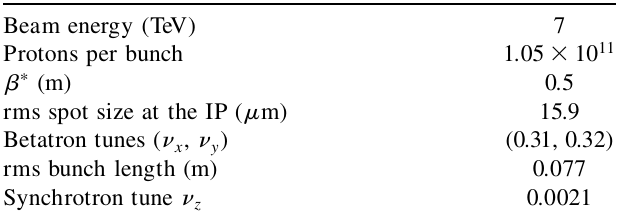
TABLE I. LHC nominal beam-beam parameters.